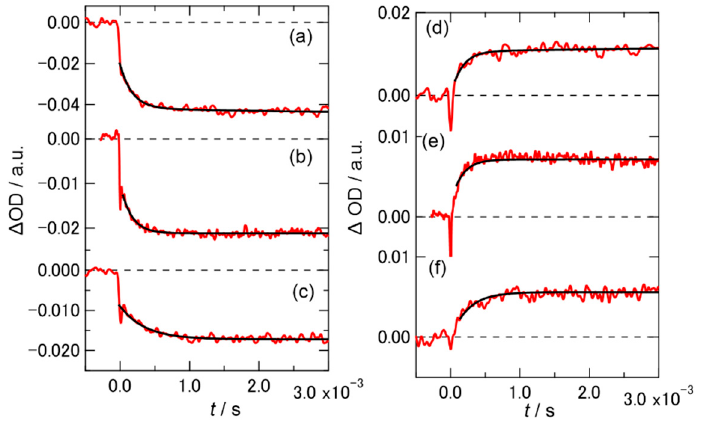
Figure 3. Time profile of the TA at 436 and 365 nm for PYP in ( a , d ) 10 wt%, ( b , e ) 30 wt%, and ( c , f ) 49 wt% Hy[ch][dhp]; ( a – c ) 436 nm, ( d – f ) 365 nm. Schemes follow the same formatting.